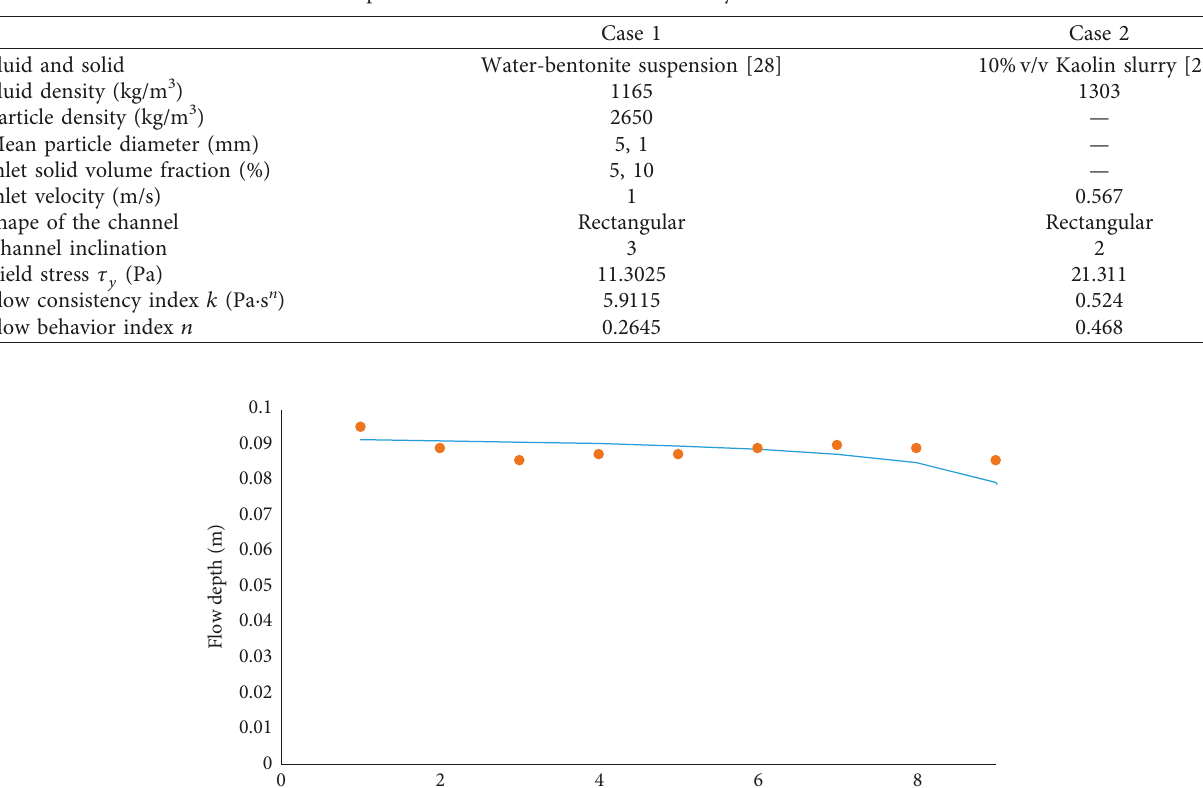
Table 2: Simulation flow parameters. Case 1 is used in this study. Case 2 is used for model